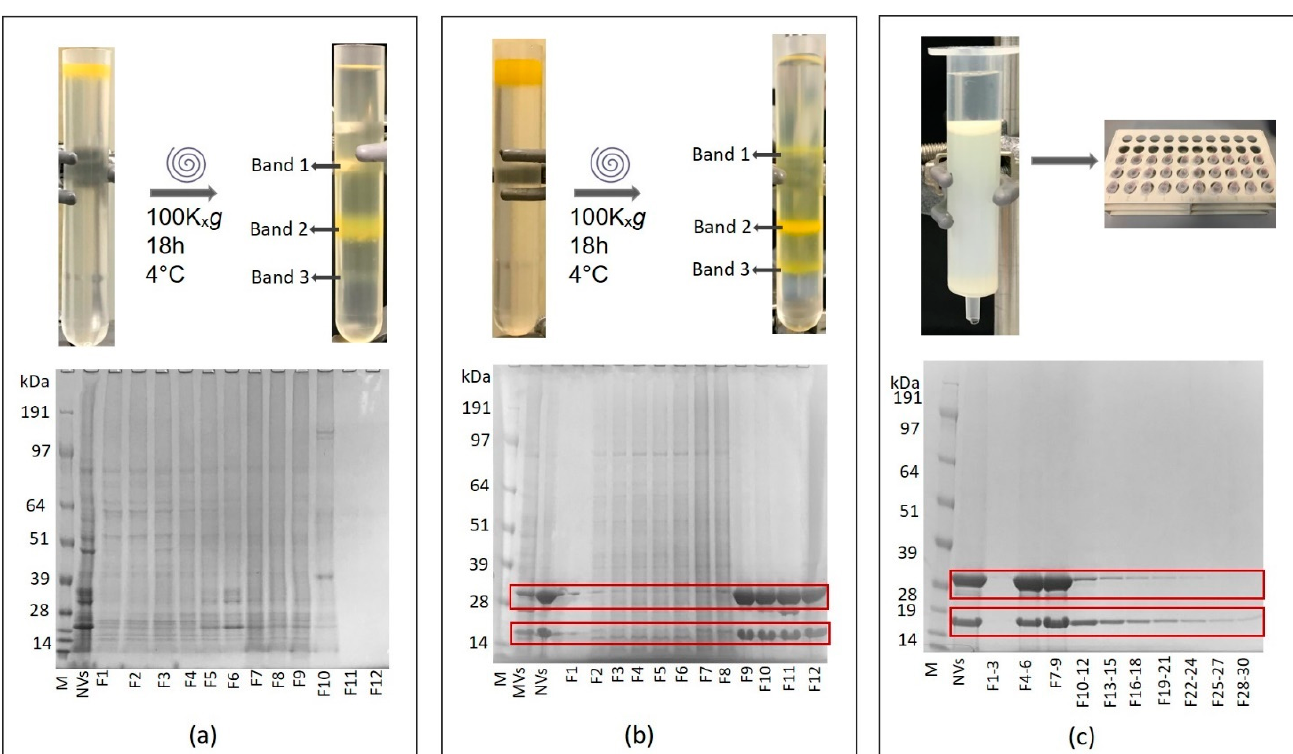
Figure 4. Sodium dodecyl sulfate–polyacrylamide gel electrophoresis protein profiles of ( a ) bulk tomato nanovesicles (NVs) without virus and the density-separated fractions F1–F12, ( b ) bulk tomato NVs containing viral particles and density separated fractions F1–F12 and ( c ) size-exclusion chromatography of virus containing NVs. NVs typically elute at SEC F4-6.